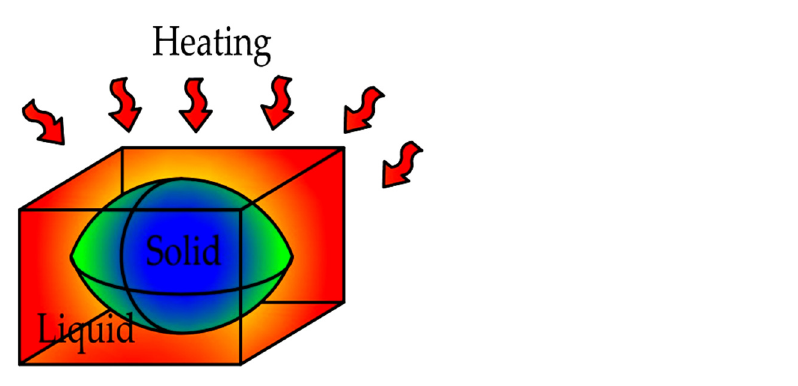
Figure 5. Graphical diagram of heating homogeneous heat accumulators containing organic